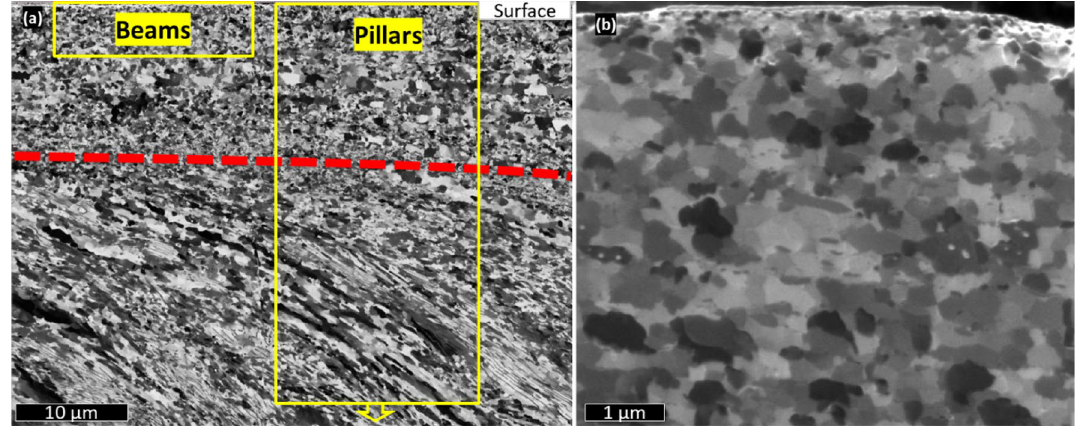
Figure 1. Ion image of the chip cross-section machined at 200 m/min. ( a ) Red dashed line is an estimation of PSZ-SSZ boundary. ( b ) Detail of the SSZ by ion scanning of chip cross-section when machining at 200 m/min. Crystals tend to equiaxiality and the diameter is consistently in the sub-micrometer